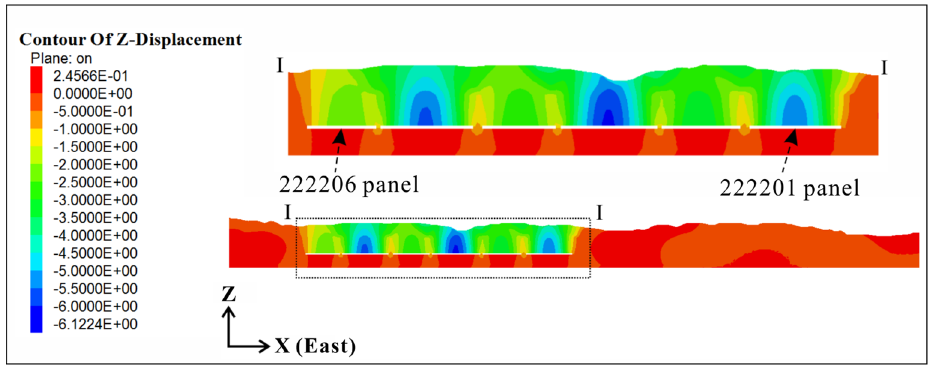
Figure 10. The longitudinal section (along the mining direction) of the S 1 contour of 6 panels.